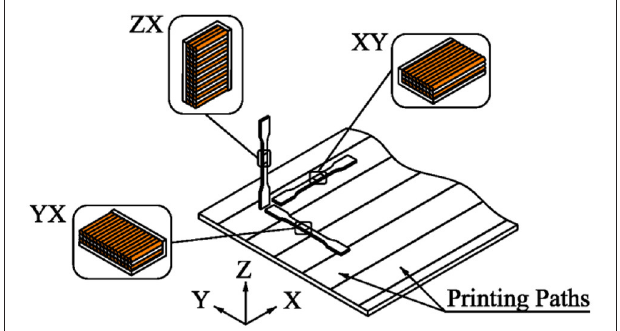
FIGURE 1 | Studied build orientations of the tensile test specimens for investigating the mechanical and dimensional properties, depending on the orientation. Subsequent layers are indicated by an alternating orange-and-white shading, whereas, intersections within the layers, resulting from material deposition of adjacent nozzles, are indicated as cylinders (not in